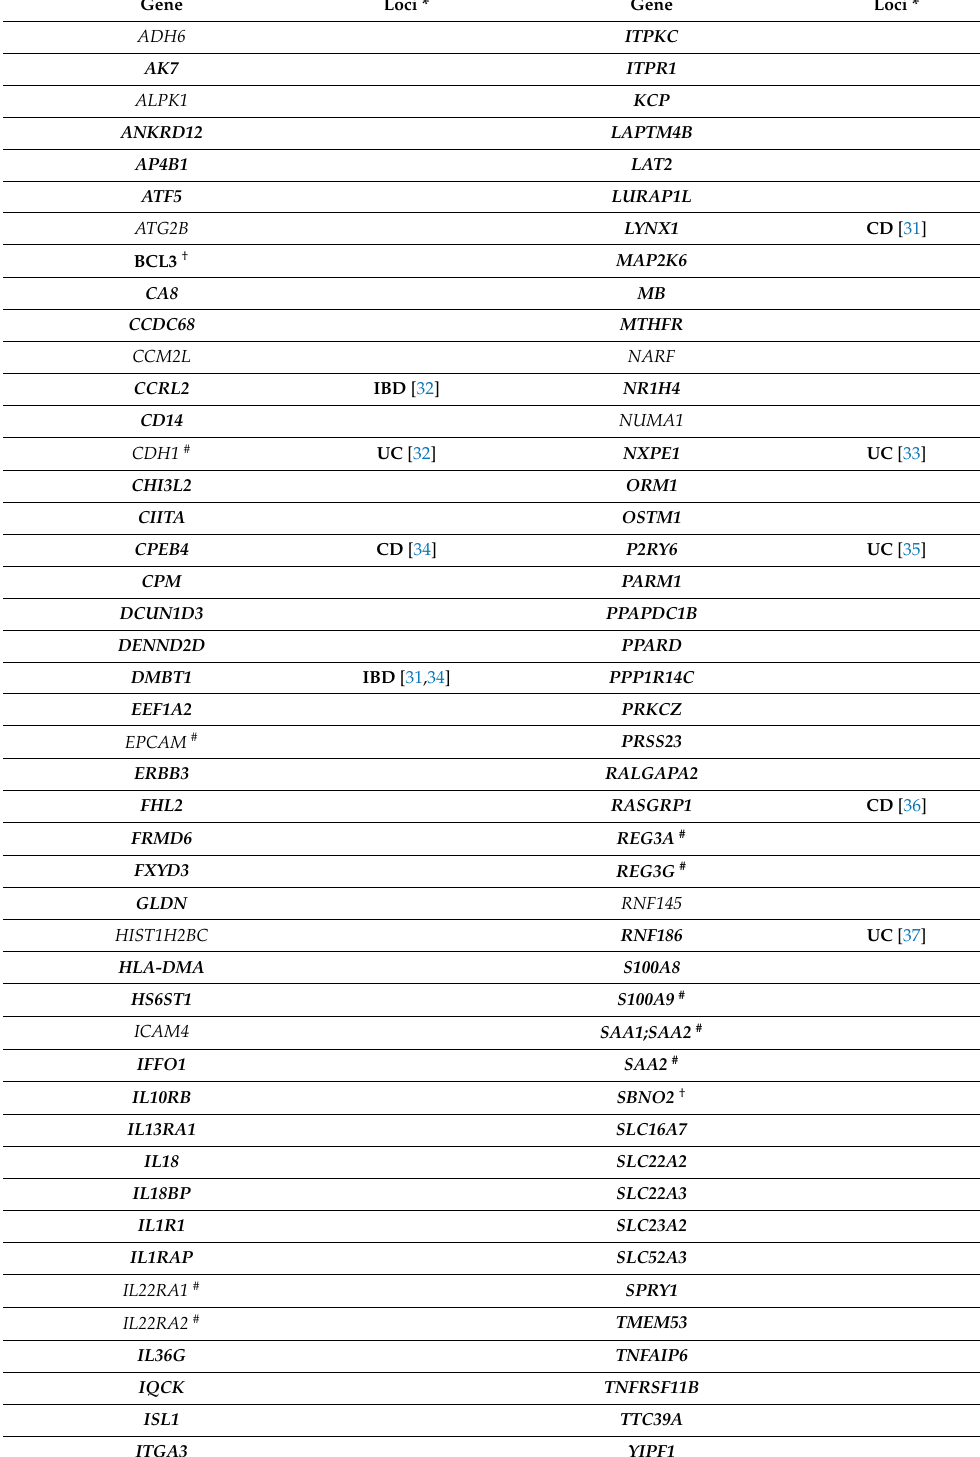
Table 1. Genes upregulated by